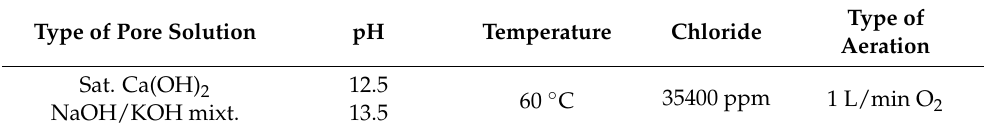
Table 2. Experimental conditions.